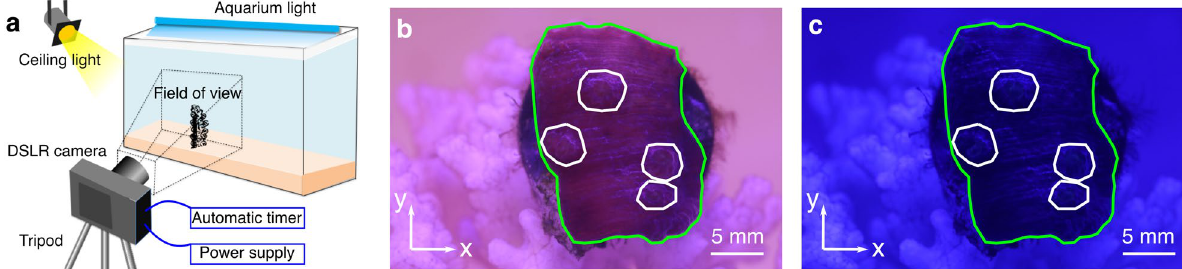
Figure 1. Experimental observation of Montipora capricornis. ( a ) Schematic of experimental setup of a DSLR camera, aimed at the corals in the aquarium. ( b ) Daylight pictures were taken under white light, while ( c ) nighttime pictures were taken under blue light. The green curves in ( b ) and ( c ) enclose the coral tissue surface. The white curves in ( b ) and ( c ) enclose the polyps. Scale bars are shown in ( b ) and ( c